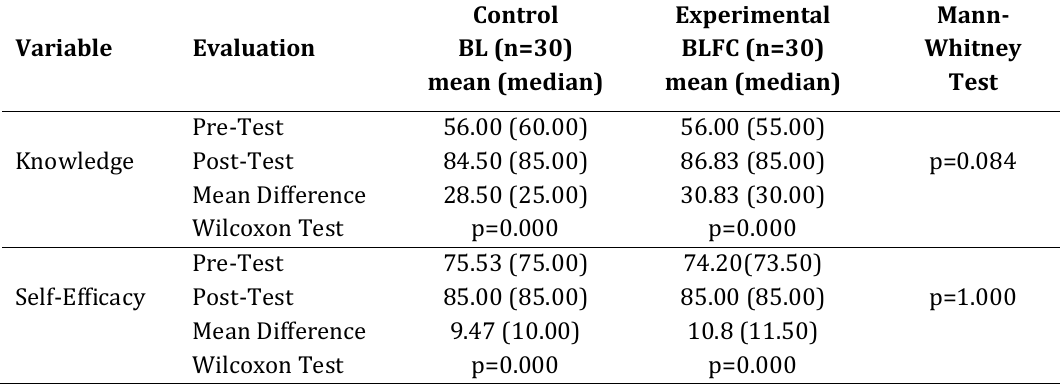
Table 1 The Knowledge Level and Self-Efficacy Improvement among Nurses in Control (BL) and Experimental Group (BLFC) Before and After the Learning Session